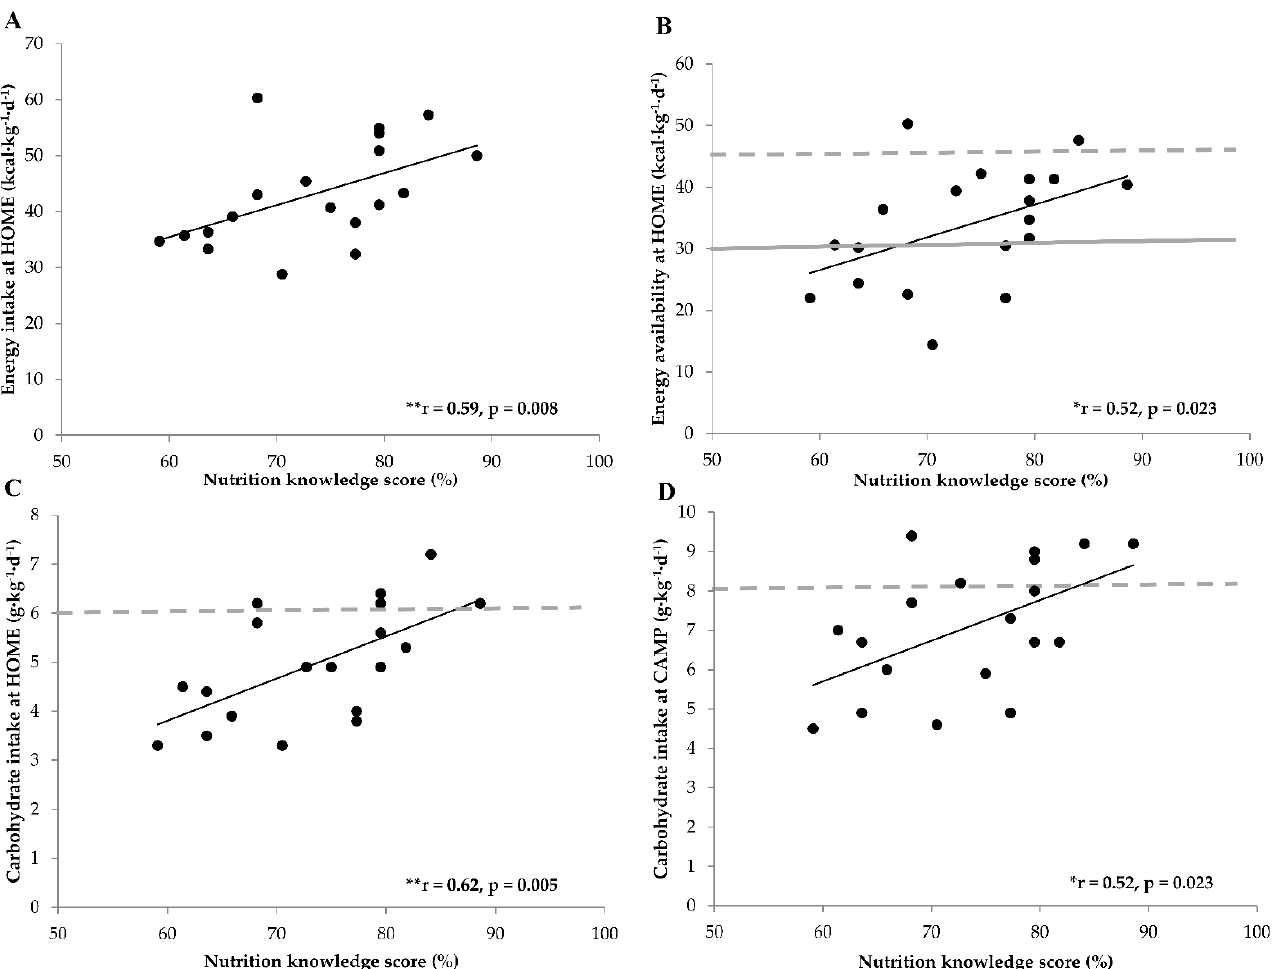
Figure 1. Associations between nutrition knowledge score and daily energy intake ( A ), energy availability ( B ), and carbohydrate intake ( C , D ). The gray horizontal dotted line denotes the consensus statement recommendations for optimal energy availability and carbohydrate intake [10,13]. The gray horizontal line denotes the threshold for low energy availability [10]. HOME = during home training; CAMP = during training camp; * p < 0.05; ** p < 0.01 significant correlation.